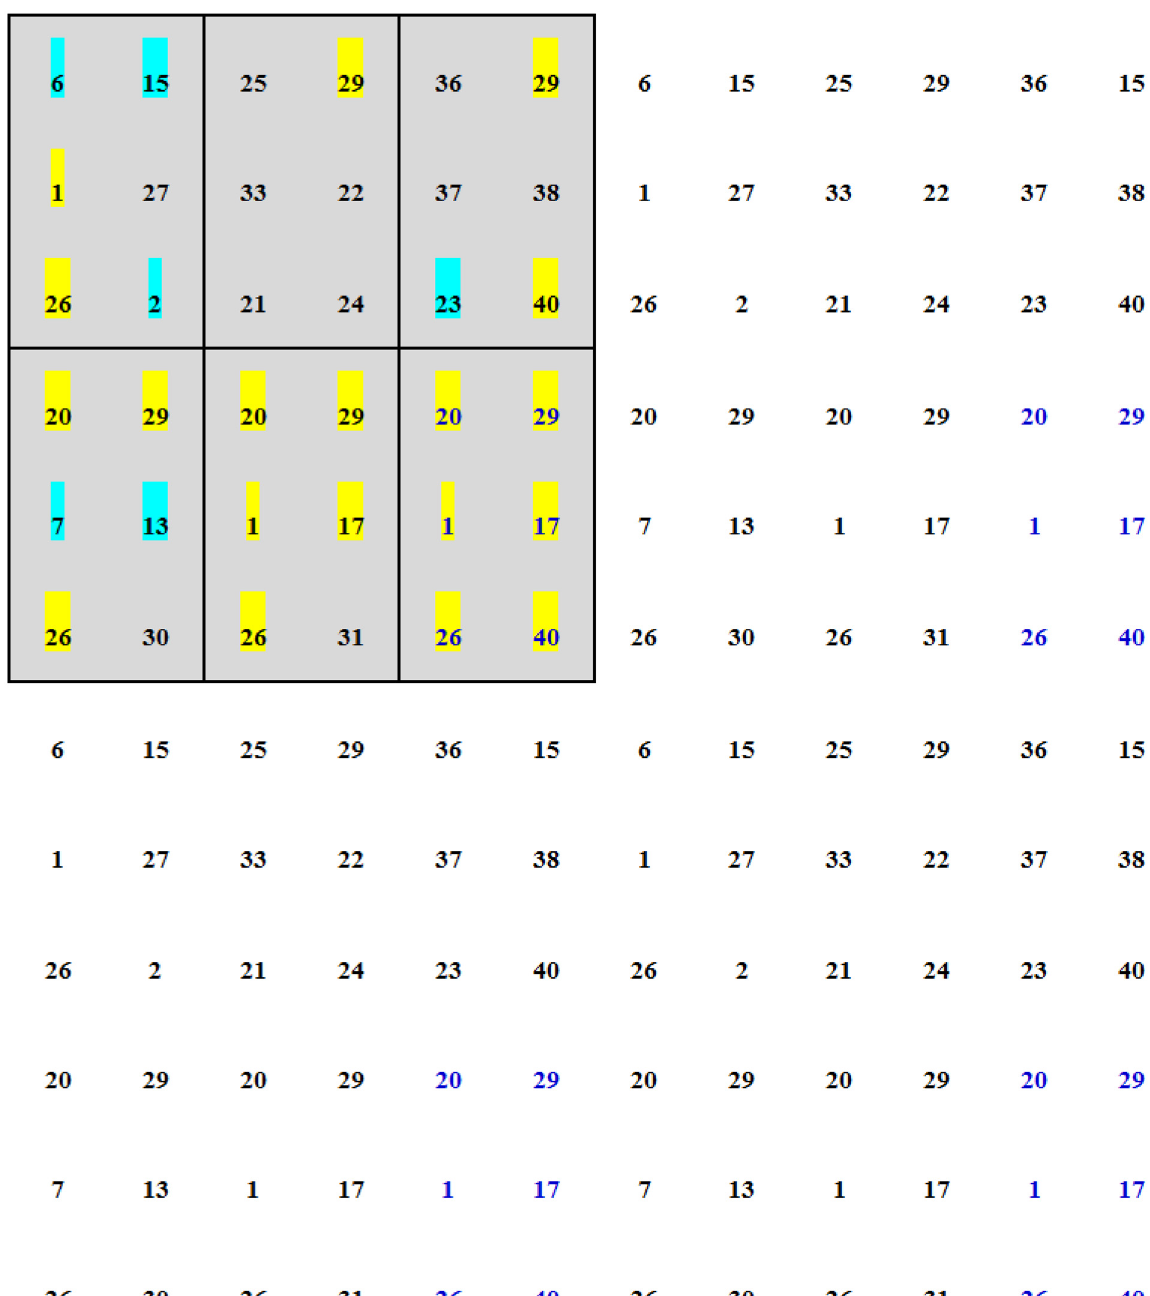
Fig 4. Field deployment for the second-generation Chinese pine seed orchard in Zhengning. Note: Number represents family no. Families in the same rectangle belong to the same deployment group (G d ). Families in blue belong to the G d added. Families with yellow shading, blue shading, and without shading are the best, worst, and moderate families, respectively. The grey shaded areas represent one complete block, and four blocks are shown.